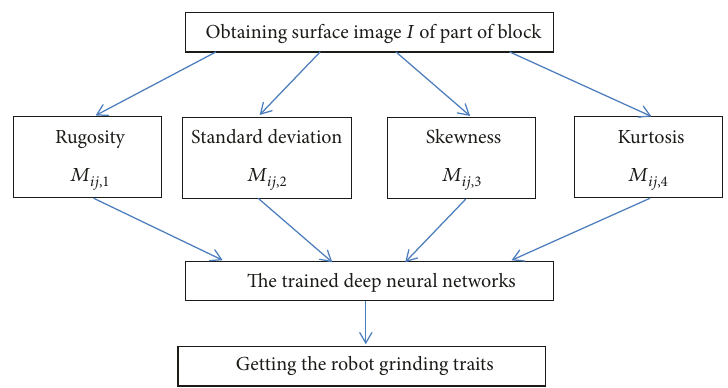
Figure 9: Prediction algorithm framework of controller parameters of grinding